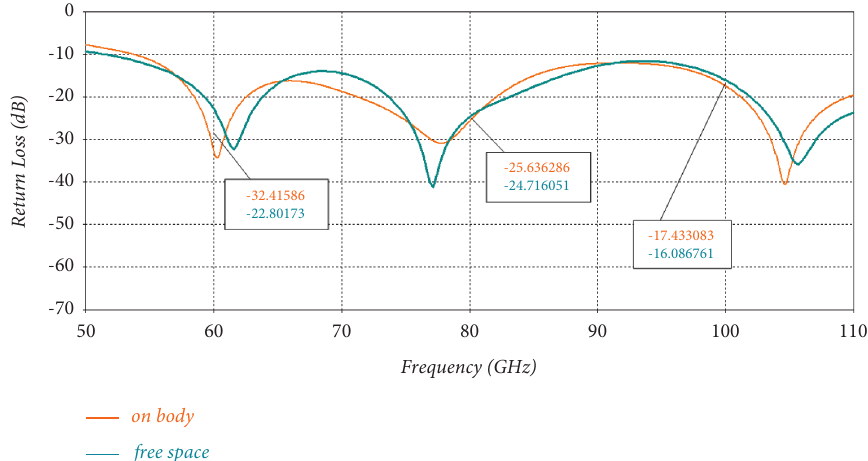
Figure 7: Comparison curves for free space and on-body return